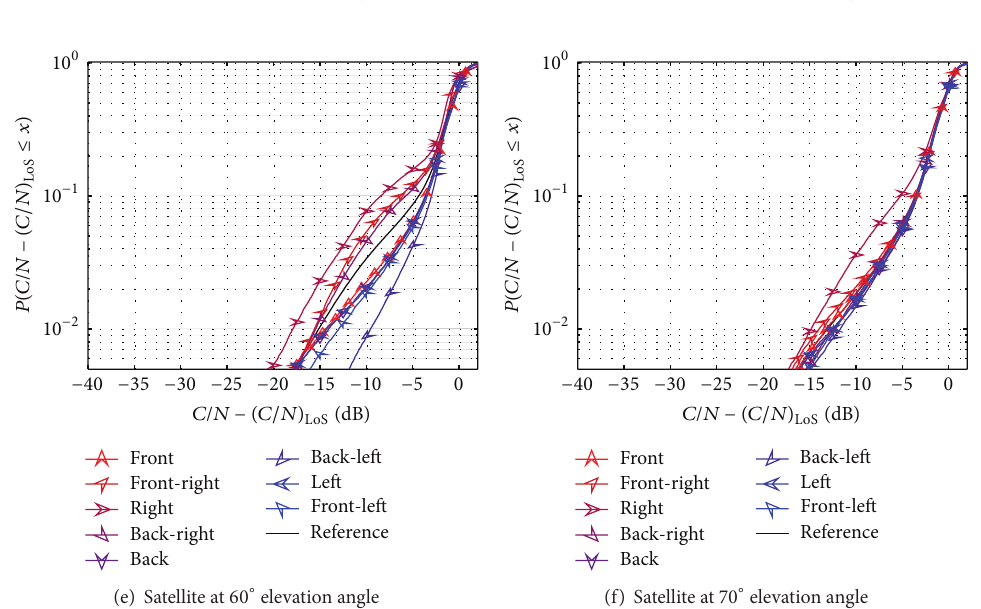
Figure 17: Comparison between the traditional and the proposed channel model with respect to the CDF of the received satellite signal envelope. For the results we consider data that has been collected in suburban environment and each plot is related to a different elevation